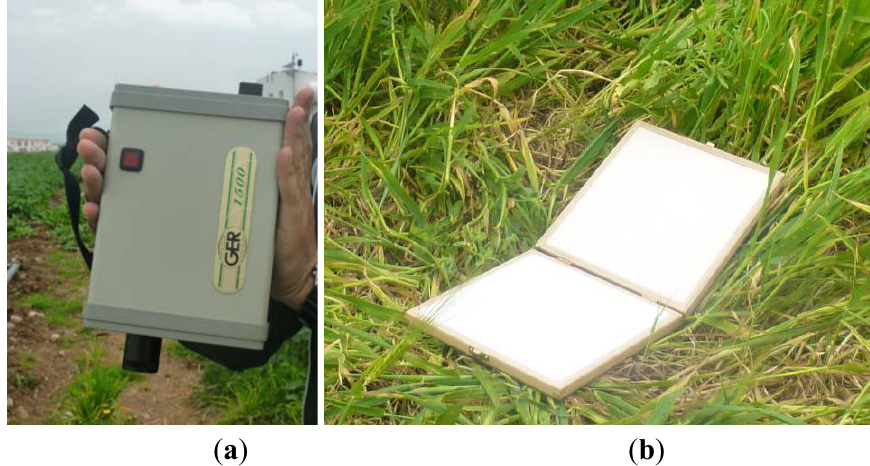
Figure 2. ( a ) The ground spectroradiometer GER 1500 used in order to collect the spectral signatures from the “archaeological” and non-archaeological area. ( b ) The calibrated spectralon